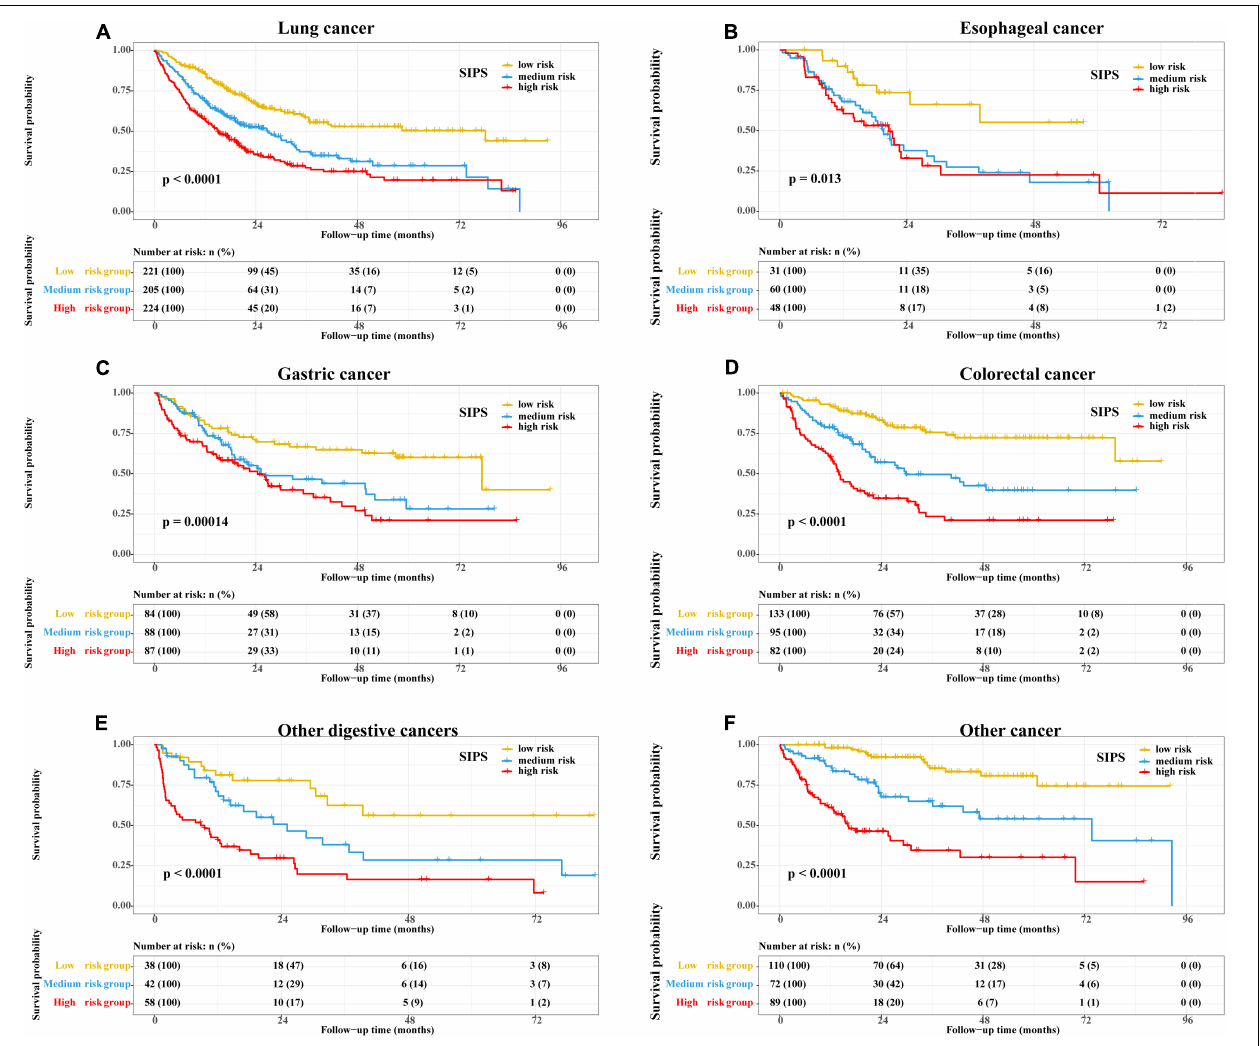
FIGURE 4 | The Kaplan–Meier survival curves of SIPS stratified by different tumor types. (A) Lung cancer; (B) Esophageal cancer; (C) Gastric cancer; (D) Colorectal cancer; (E) Other digestive cancers; and (F) Other cancer. CRP: C-reactive protein; SIPS: systemic inflammation prognostic